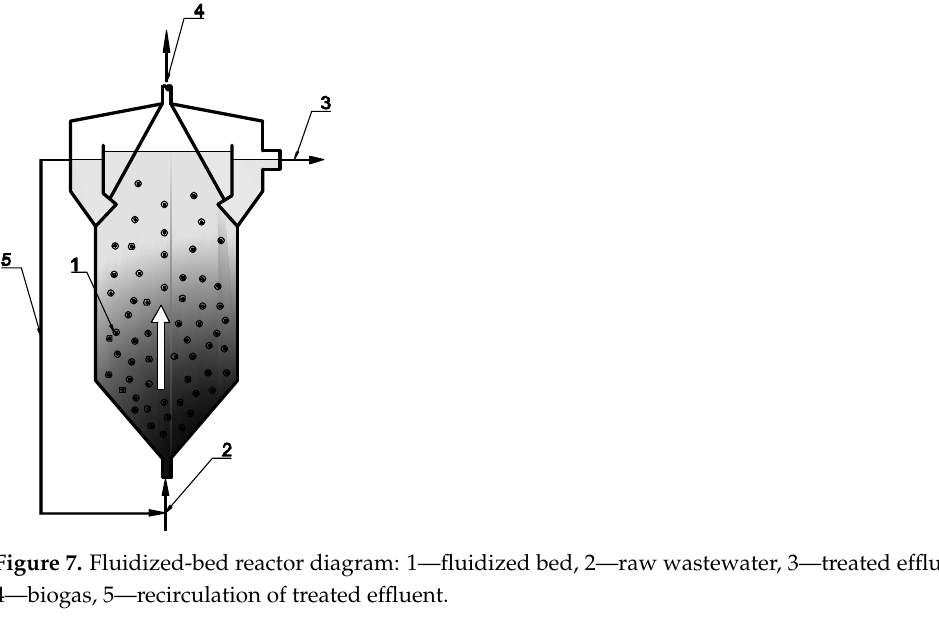
4—biogas, 5—recirculation of treated effluent.